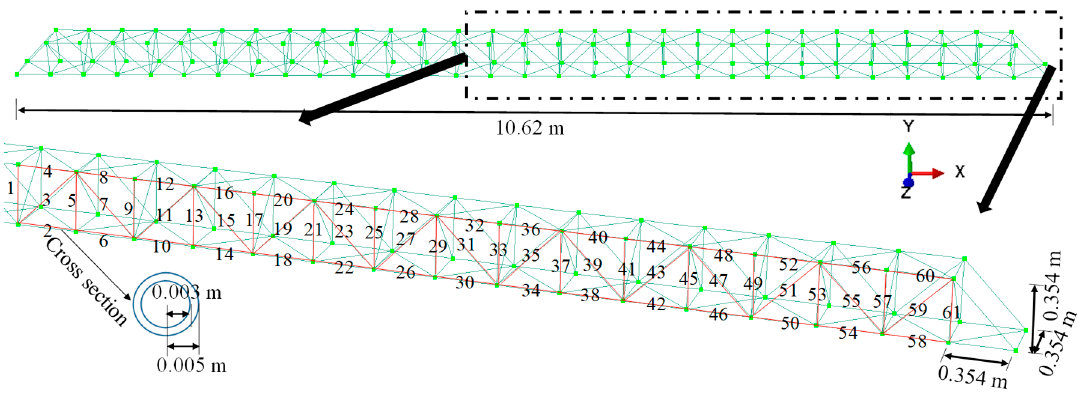
Figure 5. Numerical model of the steel frame with 381 rods.